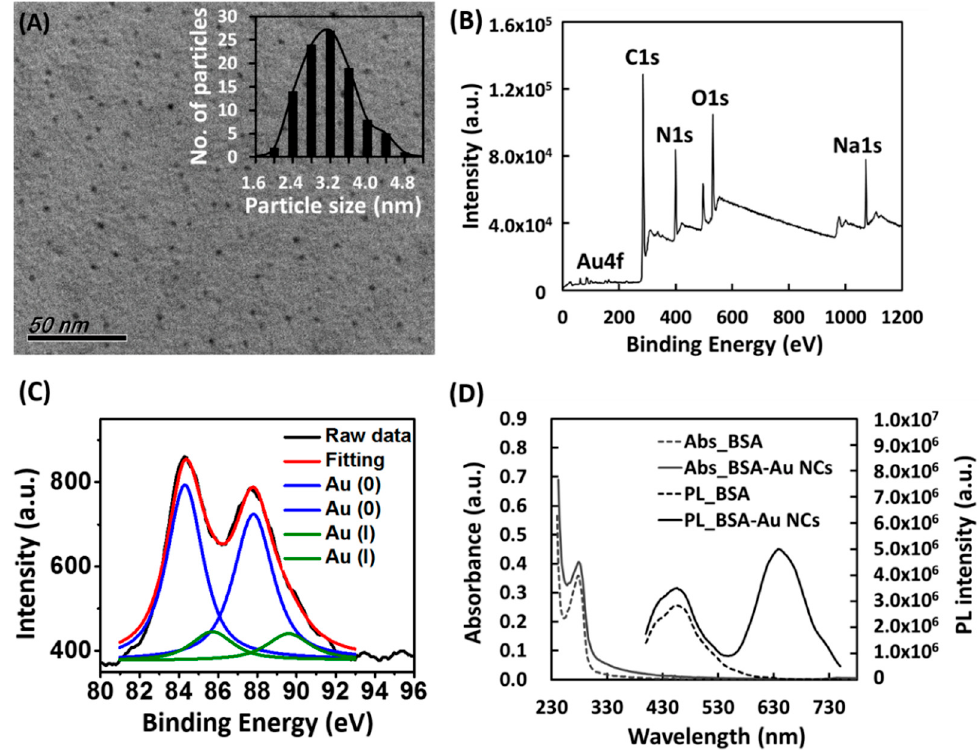
Figure 1. ( A ) TEM image, and ( B ) XPS spectrum of BSA-Au NCs. ( C ) XPS spectrum of BSA-Au NCs